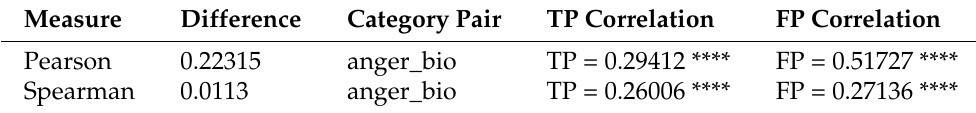
Table 42. Anger and Bio in Low.